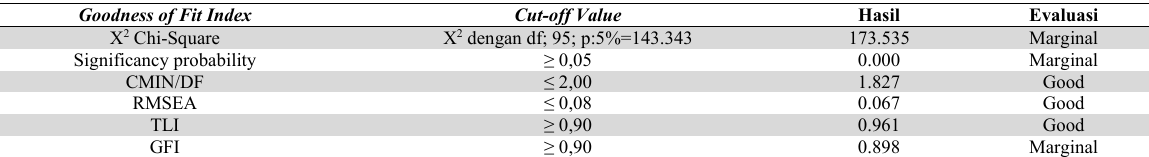
Model test results